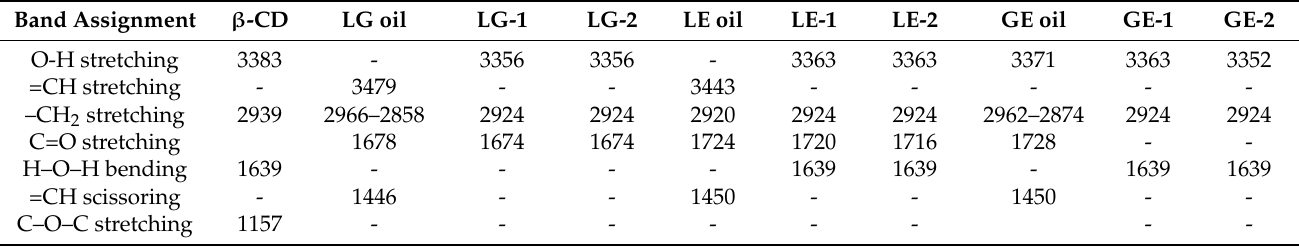
Table A2. Summary of FT-IR analysis of β -cyclodextrin ( β -CD), lemongrass essential oil, (LG oil), inclusion complexes LG-1 and LG-2, lemon eucalyptus essential oil, (LE oil), inclusion complexes LE-1 and LE-2, geranium Egyptian essential oil, (GE oil), geranium Egyptian inclusion complexes GE-1 and GE-2. All values are in cm − 1